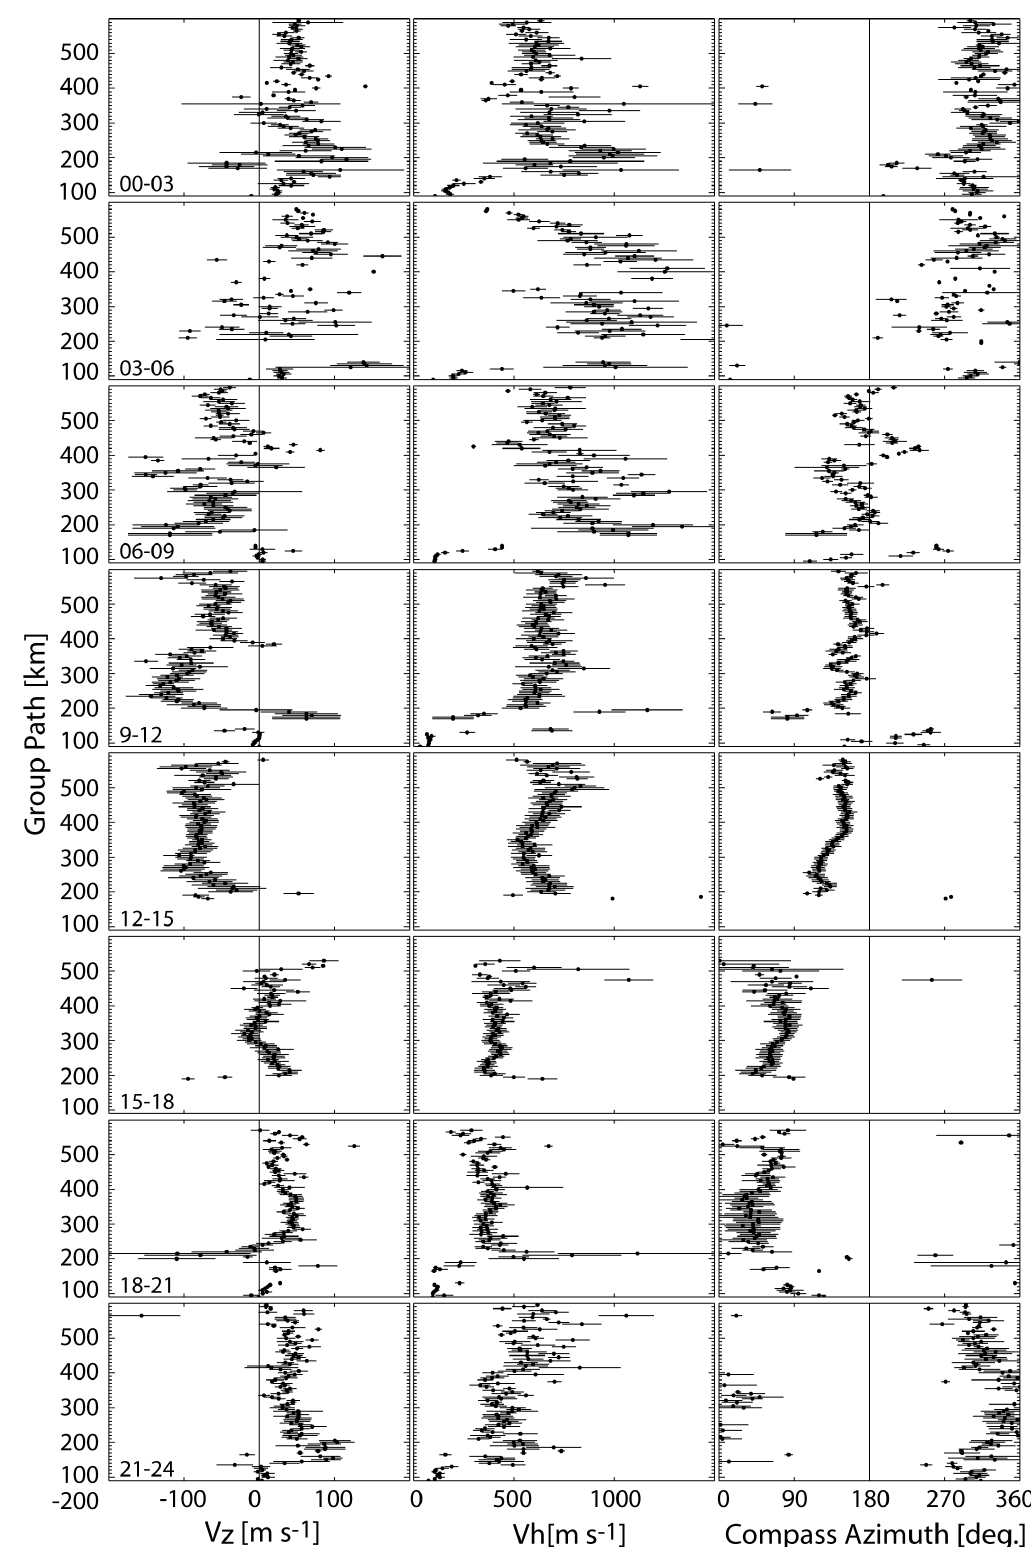
Fig. 1. Three-hourly averaged ionospheric drift velocities recorded over Casey station for 16 December 1996 as a function of the group path. The velocity components are expressed in a compass-oriented coordinate system. Azimuth angles are measured positive eastwards from compass north ( ∼ 92 ◦ west of geographic north). Large error bars are associated with late morning and early afternoon drift measurements in the 03:00 to 06:00 UT and 06:00 to 09:00 UT time intervals (magnetic local noon corresponds to ∼ 06:30 UT at